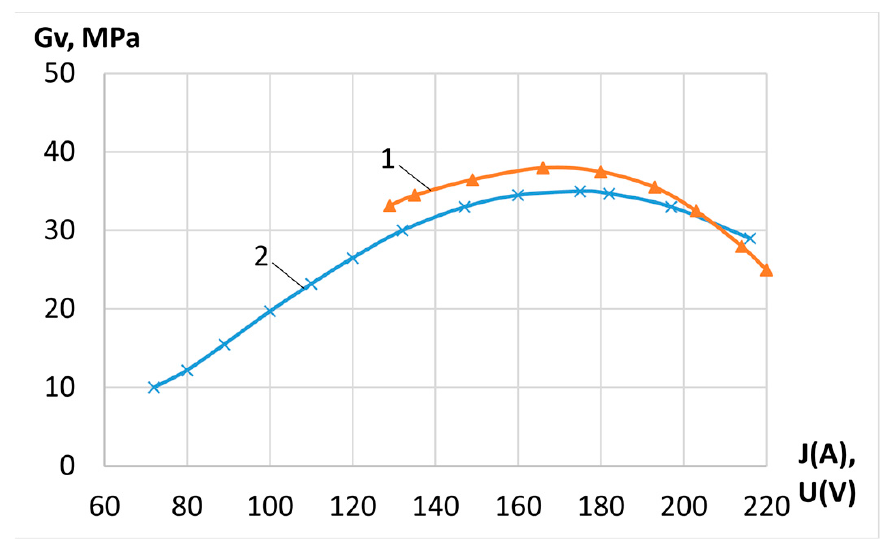
Figure 2. Dependence of the change in the adhesion strength of the coating on the voltage charac- teristics of the modes: 1—from the current density J; 2—from the arc voltage U.